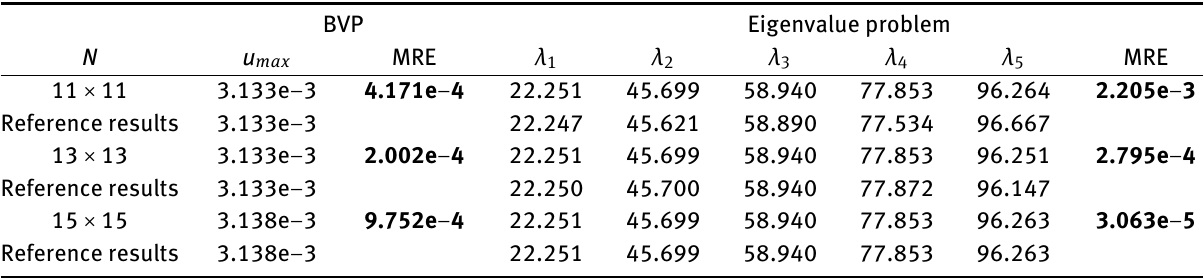
Table 8: The results from solving the biharmonic problems on the triangular domain with corner cut-out. The boundary conditions given by Eq. (29) implemented using strategy